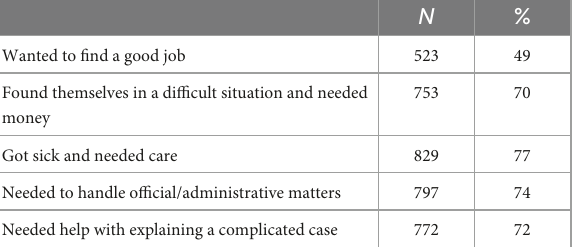
TABLE 2 Frequency ( N ) and percentage (%) social